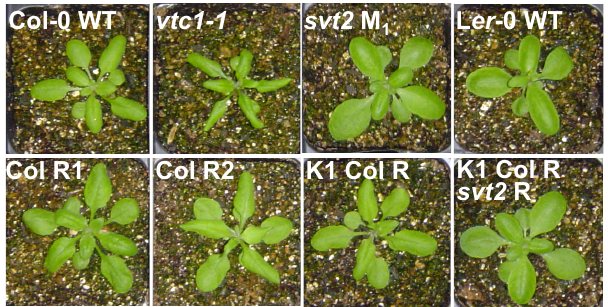
Figure 8. Phenotype of svt2 revertants. Plants were three weeks old when photographs were taken. Top row represents controls, Col-0 wild type, vtc1-1 and svt2 mutants, and L er -0 wild type. Bottom row represents three Col-like revertants, svt2 Col R1 M